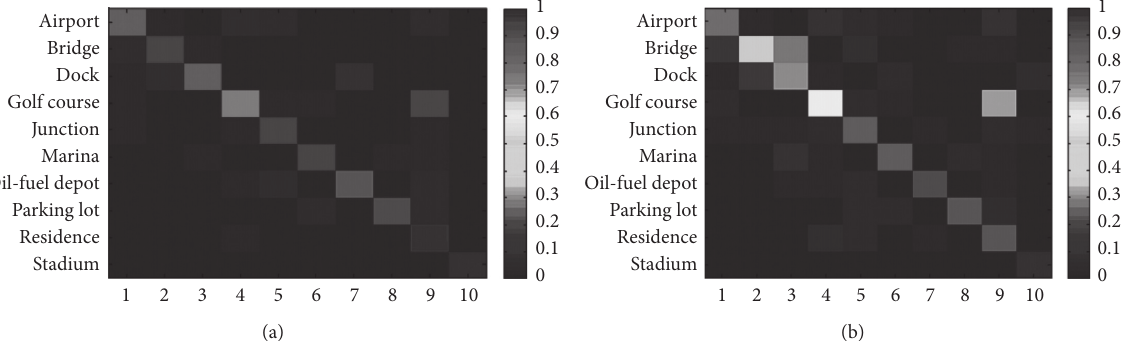
Figure 2: Scene recognition results obtained by using different recognition methods: (a) the classification mixed silk matrix obtained by ToF-KNN and (b) the classification mixed silk matrix obtained by PLSA +ToF-KNN.